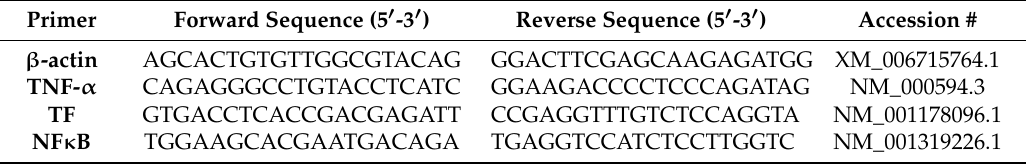
Table 1. Primer sequences employed in this study